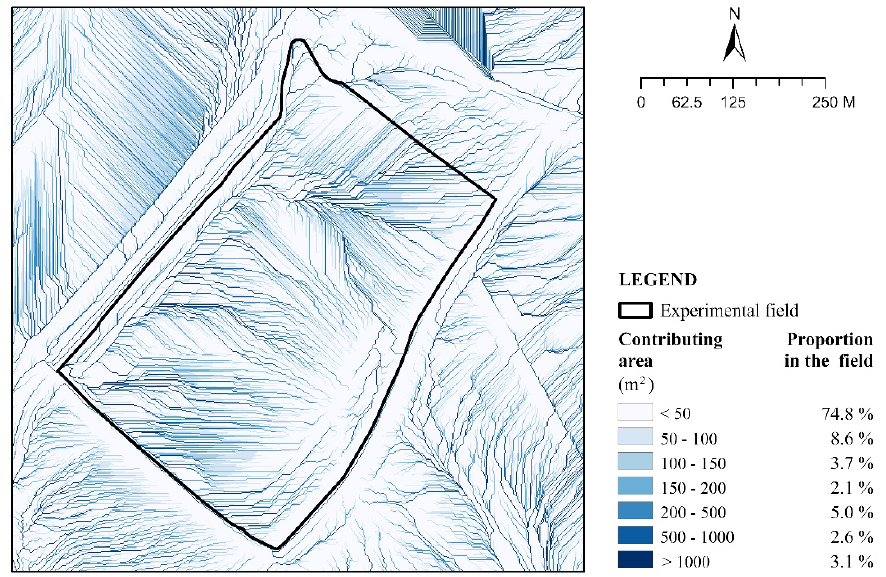
Figure 5. Contributing area used for the calculation of the potential soil loss (determined from the raw data [33]).